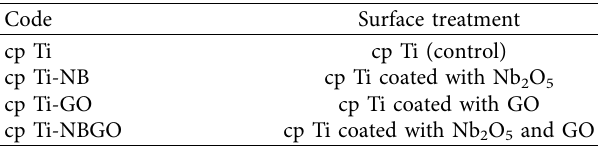
Figure 1: Schematic drawing of the electrochemical deposition cell. Te working cathode was the analyzed specimen. Table 1: Code used to identify the